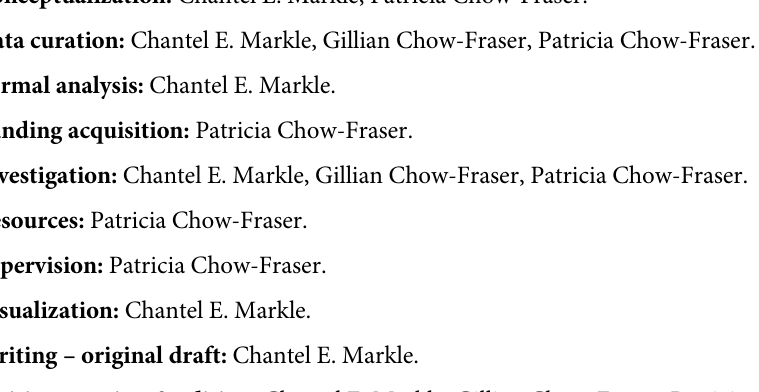
S1 Table. Landscape composition in hectares in Point Pelee National Park from 1931 to 2015. Habitat types are presented according to the greatest amount of change between 1931 and 2015. The quality of the 1990 image prevented classification beyond the marsh community class and therefore we have no data (nd) for ecosites/vegetation